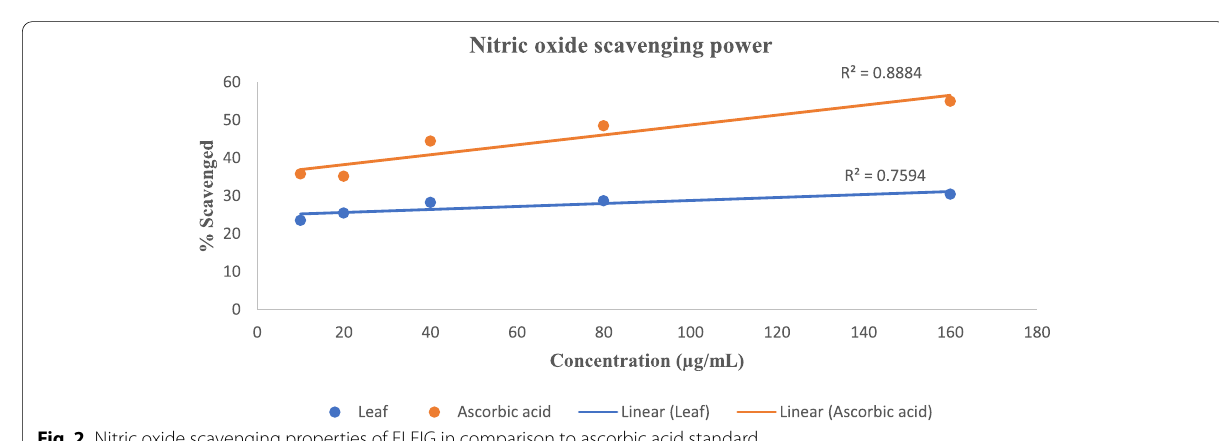
Fig. 2 Nitric oxide scavenging properties of ELEIG in comparison to ascorbic acid